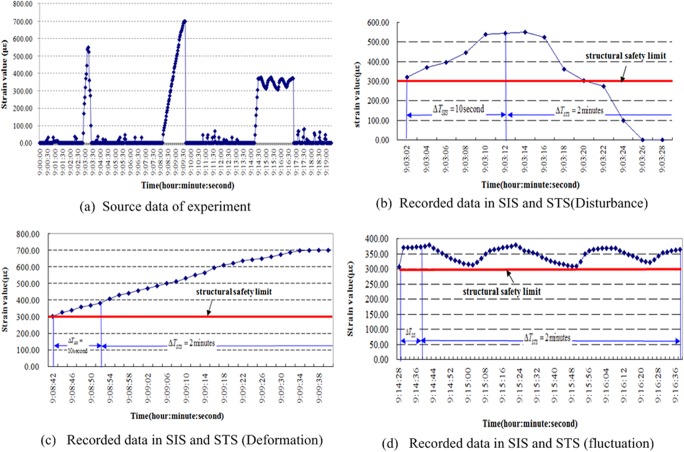
Data volume control experiment.